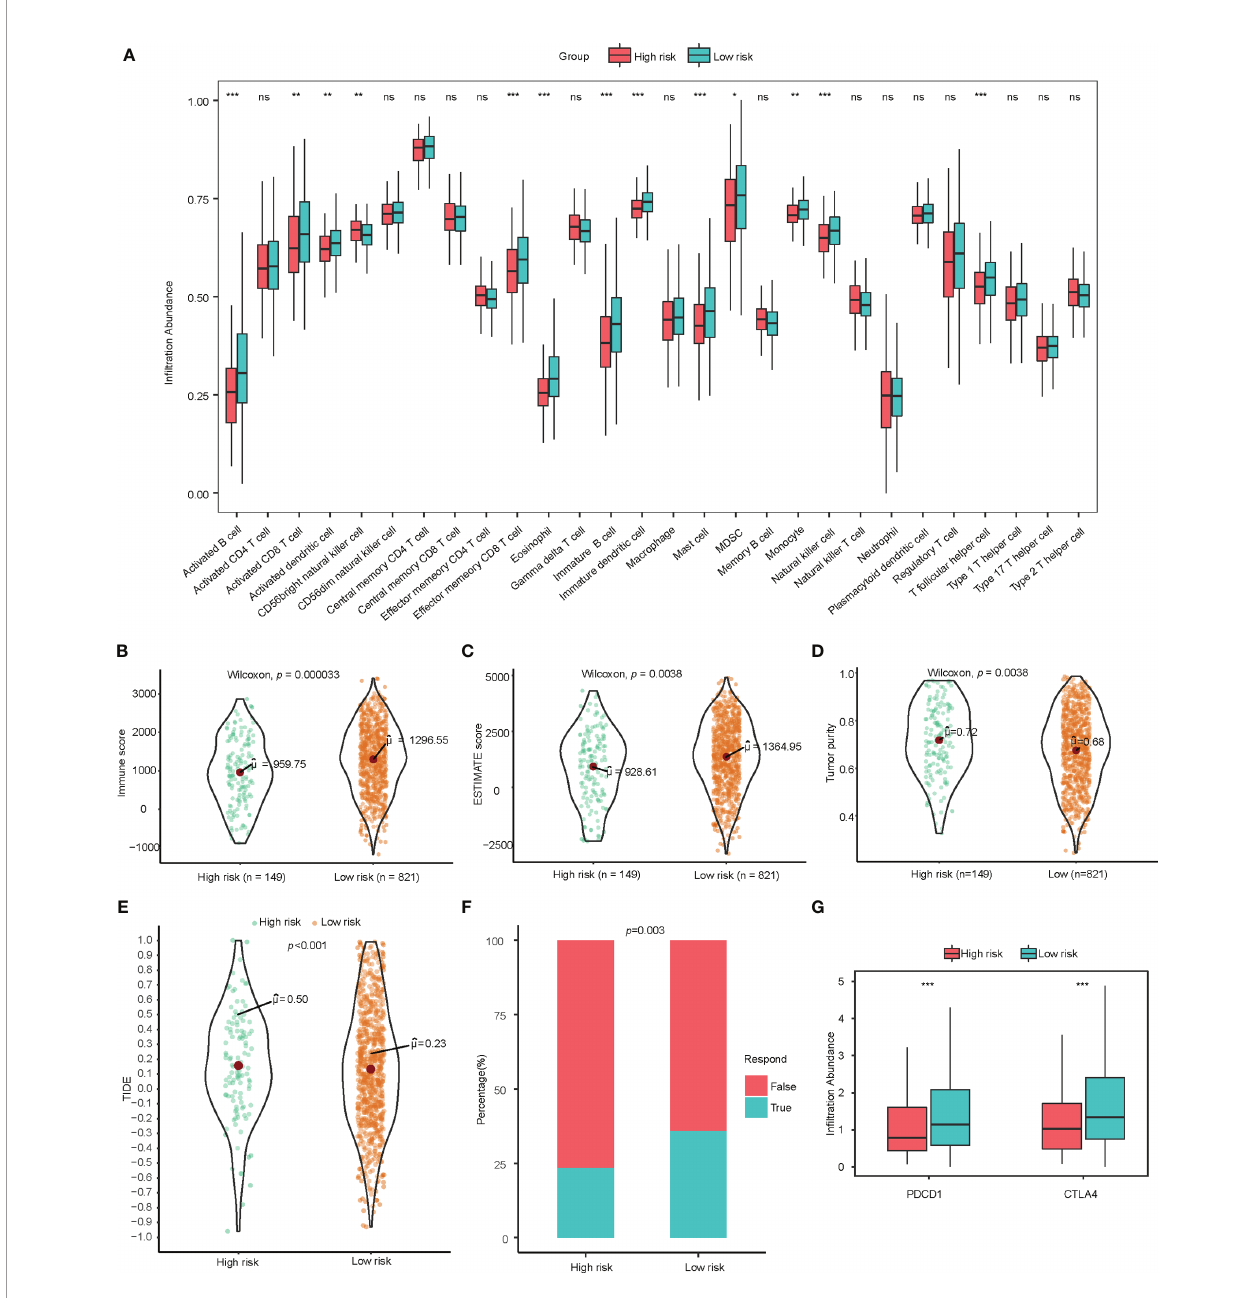
FIGURE 3 | Exploration of immune landscape and immune response. (A) Single sample gene set enrichment analysis suggested a higher proportion of multiple immune cells such as activated B cells, CD8+ T cells, CD4+ T cells, and dendritic cells. ns for p>0.001, * for p<0.001, ** for p<0.0001, *** for p<0.00001. (B – D) Higher immune score, estimate score, and lower tumor purity are analyzed by ESTIMATE algorithm. (E, F) TIDE analysis estimated T cell dysfunction and exclusion and predicted response of immunotherapy. (G) Low-risk patients showed signi fi cantly higher PD-1 and CTLA-4. lncRNA, Long non-coding RNA; ssGSEA, Single Sample Gene Set Enrichment Analysis; TIDE, Tumor Immune Dysfunction and Exclusion. ns for p>0.05, * for p<0.05, ** for p<0.01, *** for